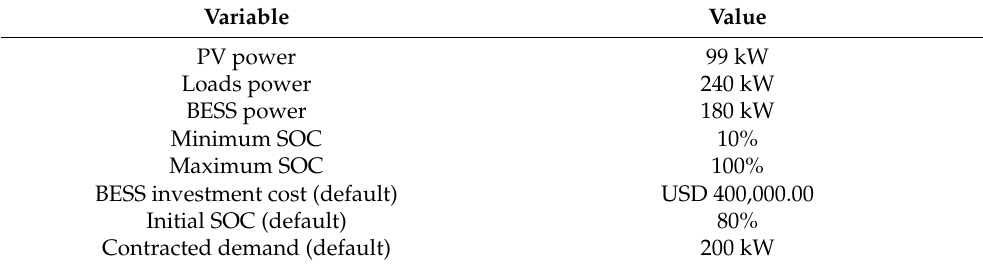
Figure 6. Microgrid architecture. Table 3. Microgrid